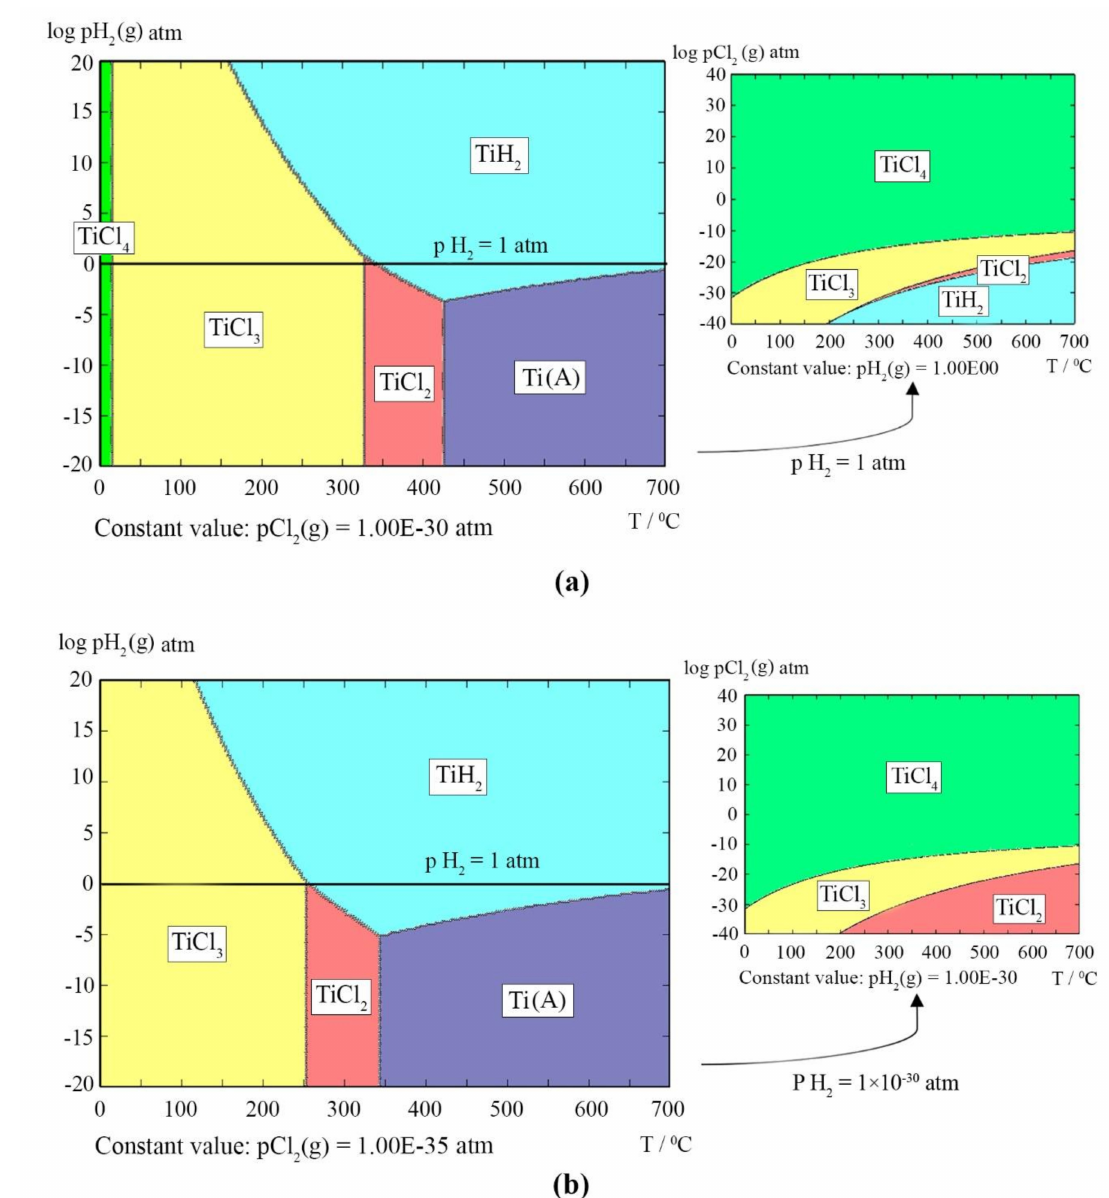
Figure 2. Ti-Cl-H predominance diagram at a partial pressure of Cl 2 ( a ) P Cl